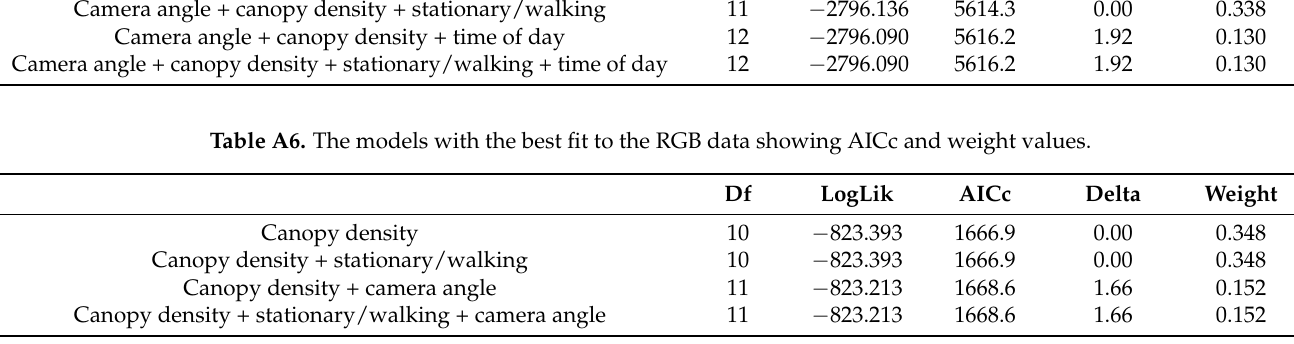
Table A6. The models with the best fit to the RGB data showing AICc and weight values.